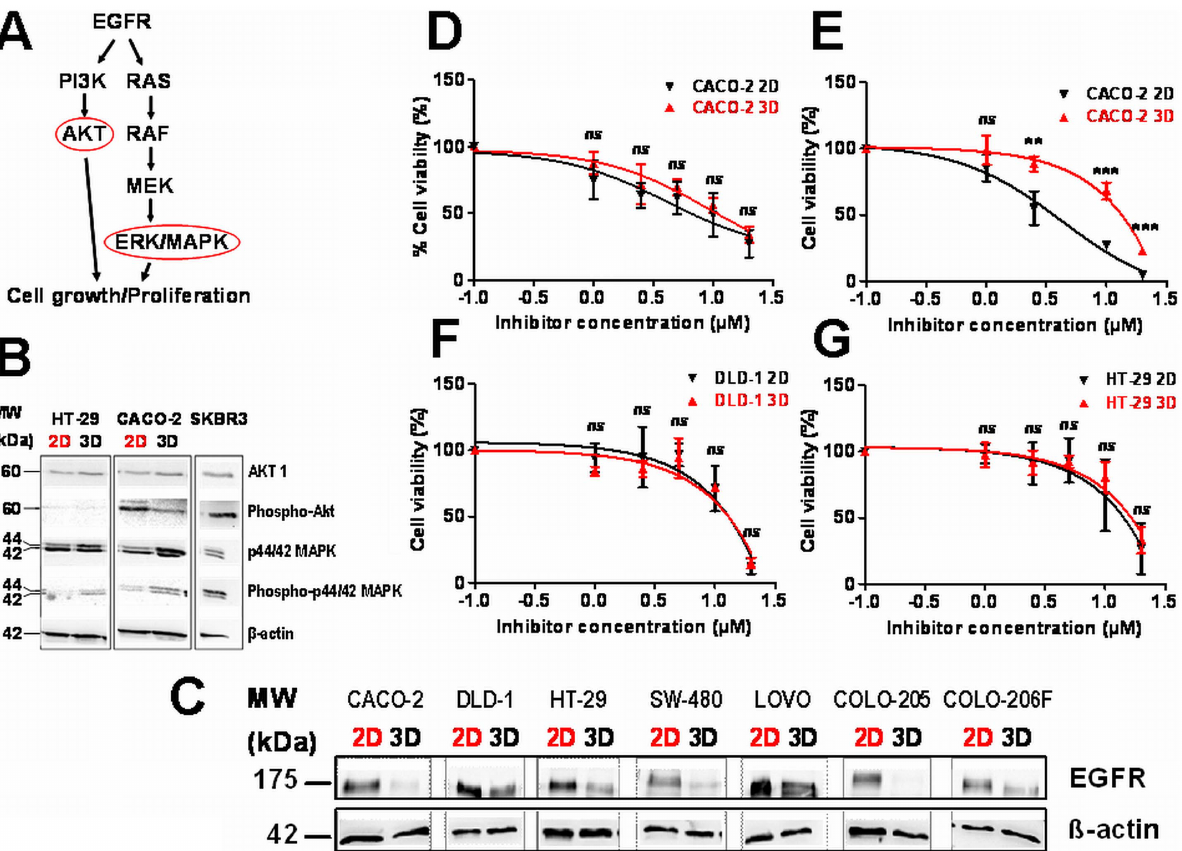
Figure 6. Influence of culture conditions on EGFR signaling molecules and EGFR inhibition of CRC cells. A) Schematic representation of the EGFR signalling pathway. B) Immunoblot analysis of AKT, phospho-AKT (S473), p44/42 MAPK and phospho p44/42 MAPK (Thr202/Tyr204). Equal amounts of total protein isolated from cells cultivated as 2D or lrECM 3D cultures were analyzed by SDS/PAGE/immunoblotting as indicated. b 2 actin served as loading control. SKBR3 served as a positive control for the expression of EGFR signaling molecules. C) Expression of the EGFR protein in 2D or lrECM (3D) cultivated CACO-2, DLD-1, HT-29, SW-480, LOVO, COLO 205 and COLO-206F cells. Cell lysate (40 m g protein per lane) was analyzed by SDS/PAGE/immunoblotting using monoclonal anti EGFR antibody. b -actin served as loading control. D–G) Treatment of 2D or lrECM cultivated CRC cells with AG1478. Two-tailed P -values were calculated by the paired t-test (** indicates a P -value , 0.001; *** indicates a P -value , 0.0001; ns=not significant). CACO-2 cells were treated for 48 h (D) or 96 h (E) with different concentrations of AG1478 as indicated. F–G) DLD-1 and HT-29 cells were incubated with the EGFR inhibitor AG1478 for 48 h.